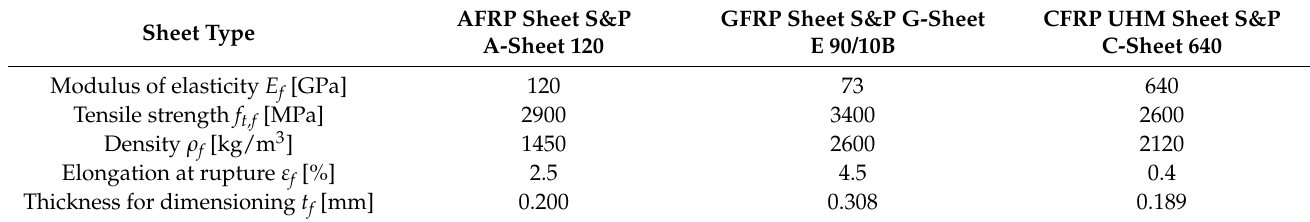
Table 3. Selected mechanical and physical parameters of composites